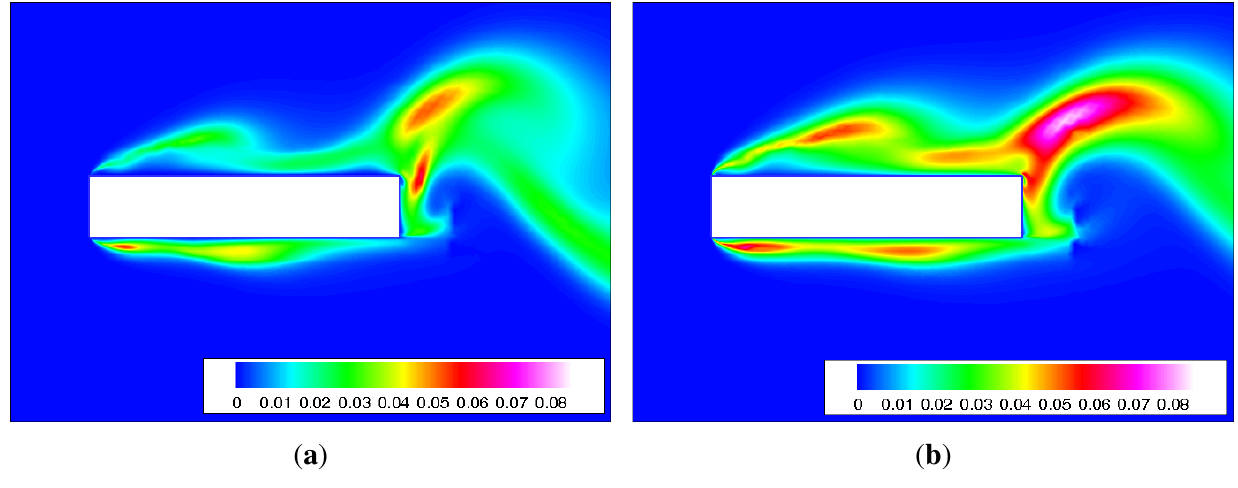
) for the rectangular 5:1 ∞